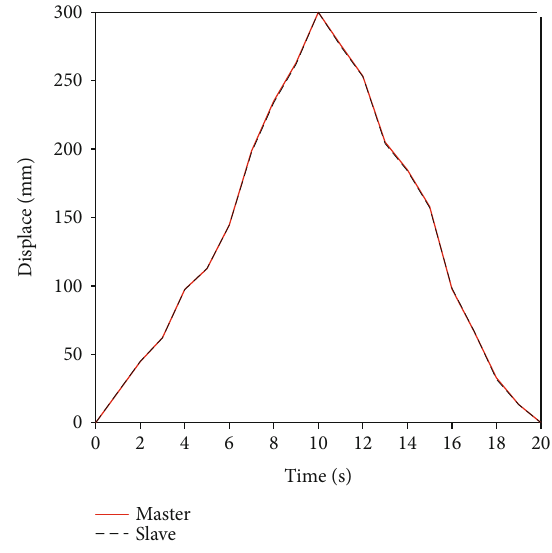
Figure 12: Axial displacement of PID